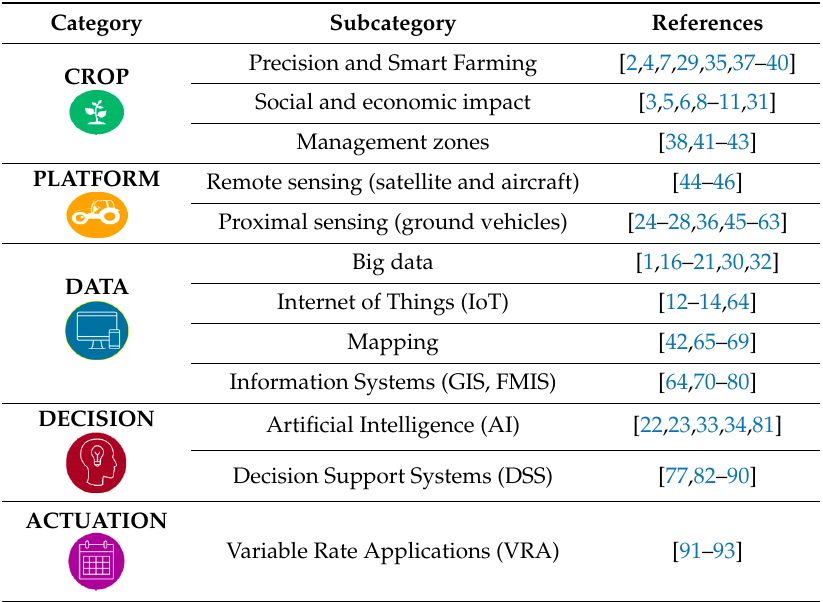
Figure 1. Information-based management cycle for advanced agriculture. Table 1. Classification of the research articles referenced in the present study.